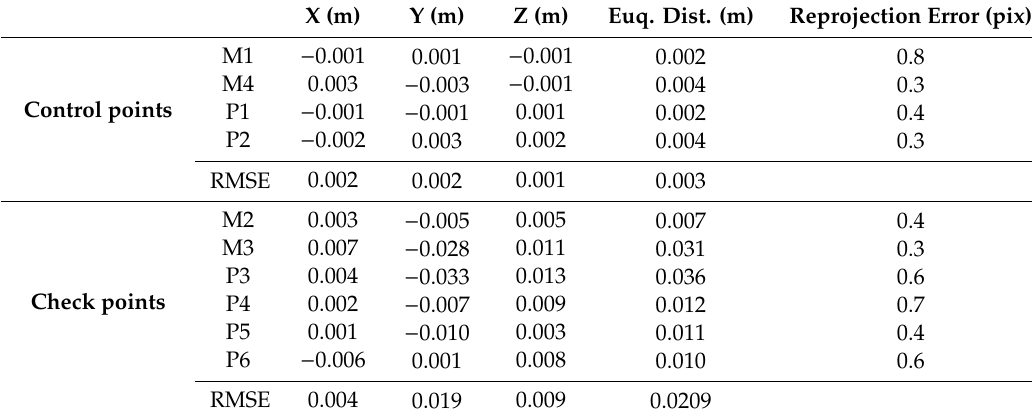
Table 4. Differences on control and check points between measured coordinates from re-processing and adjusted coordinates from new survey.